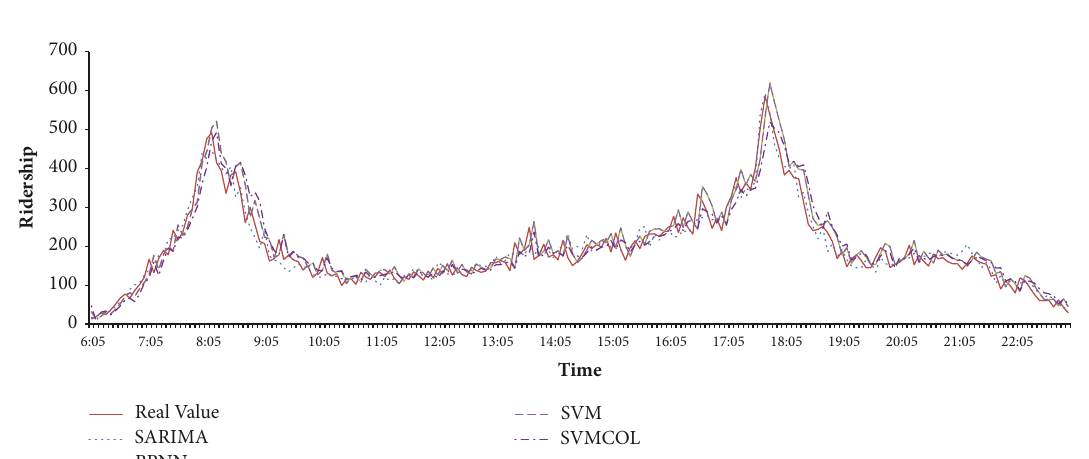
Figure6:Thecomparisonbetweentherealvalueandthepredictedvaluesby4differentmodelsusingoriginridershiptimeseriesatSanshanjie Station on November 27,